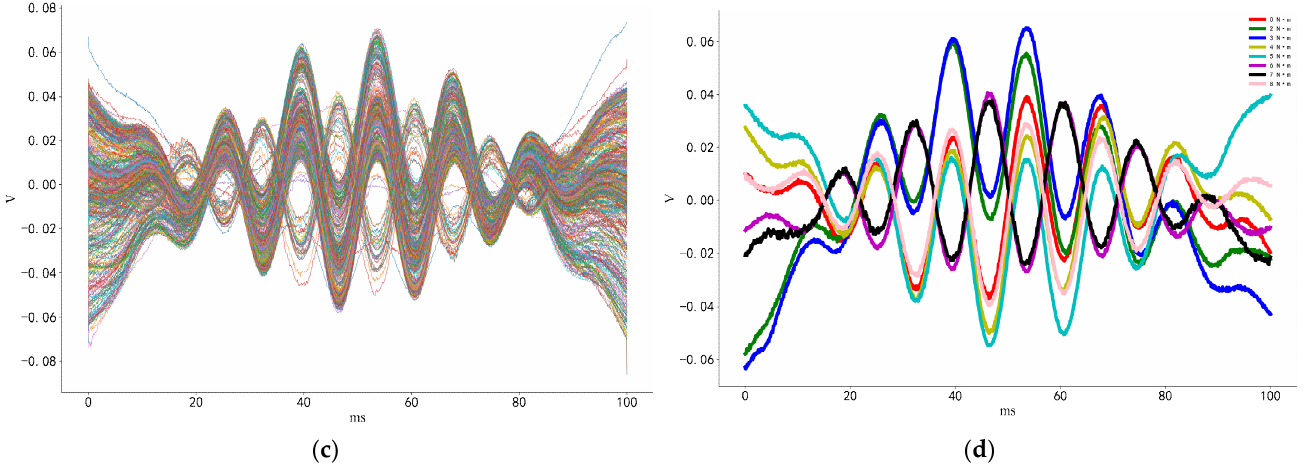
Figure 6. Results of different types of processing on directly collected signals: ( a ) directly collected signals, ( b ) normalized signals, ( c ) filtered signals, and ( d ) filtered signals obtained from randomly selected experimental signals under each preload.